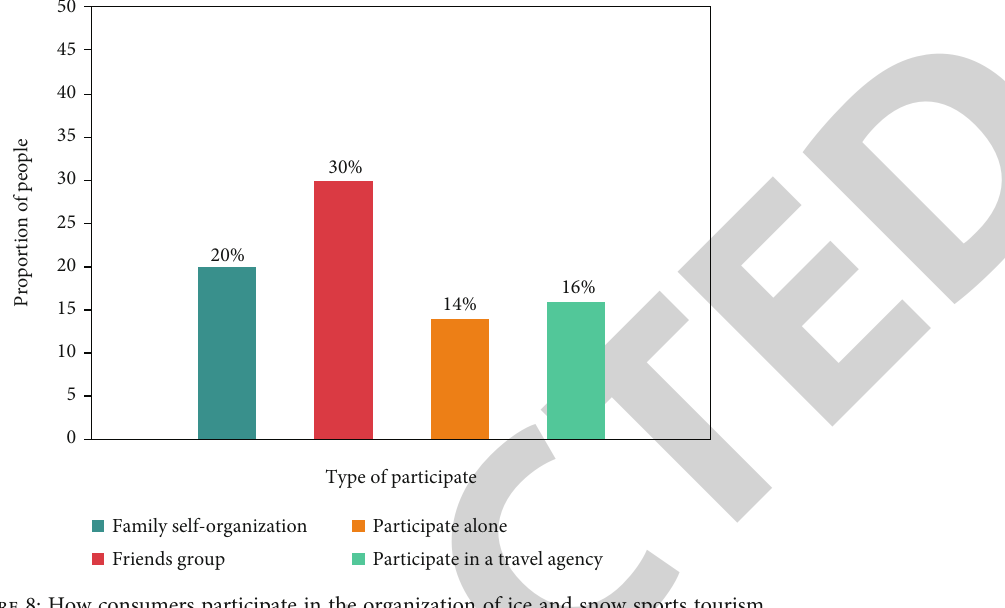
Figure 8: How consumers participate in the organization of ice and snow sports tourism. Table 4: Speci fi c breakdown of smart platform